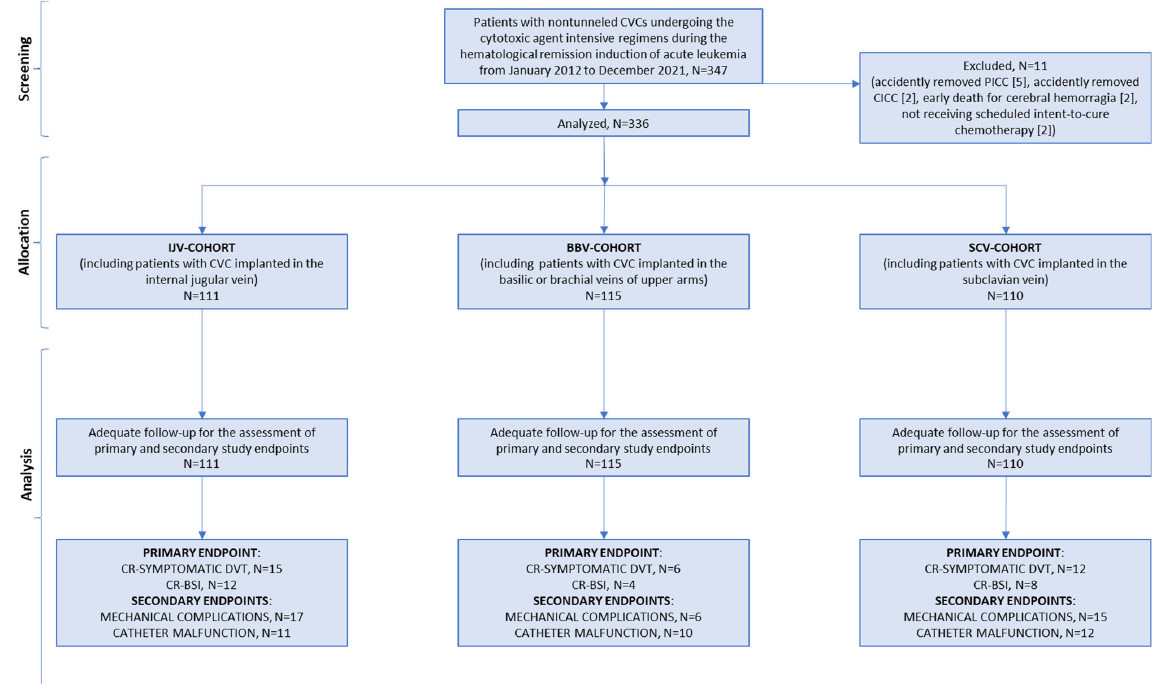
Figure 1. Diagram of the study. CVC, central venous catheter; PICC, peripherally inserted central catheter; CICC, centrally inserted central catheter; IJV, internal jugular vein; BBV, basilic/brachial vein; SCV, subclavian vein; CR, catheter-related; BSI, bloodstream infection; DVT, deep-vein thrombosis.